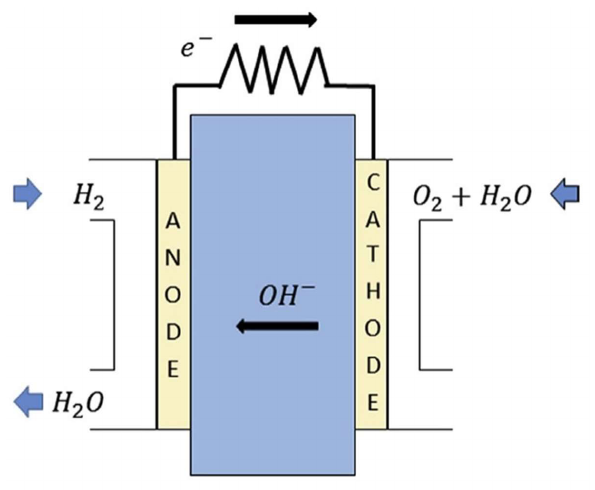
Figure 11. A schematic representation of AEMFC. Reprinted with permission from [53]. Copyright 2017, for